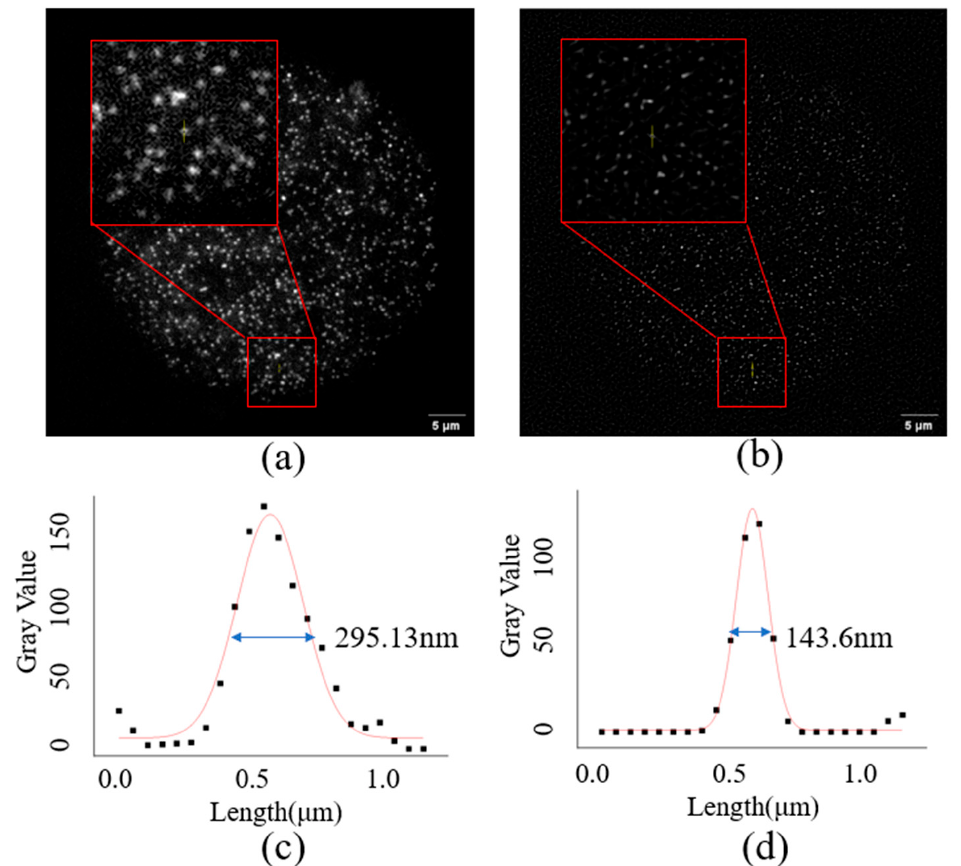
Figure 10. Imaging results of 50 nm fluorescent beads. ( a ) the result of wide-field imaging; ( b ) the imaging result after image reconstruction with N-SIM. The red line part in the figure is the enlarged figure of the corresponding position; ( c ) the full width at half maximum (FWHM) of 50 nm fluores- cent microspheres under the condition of wide-field imaging; ( d ) the FWHM of 50 nm fluorescent microspheres after N-SIM image reconstruction algorithm.